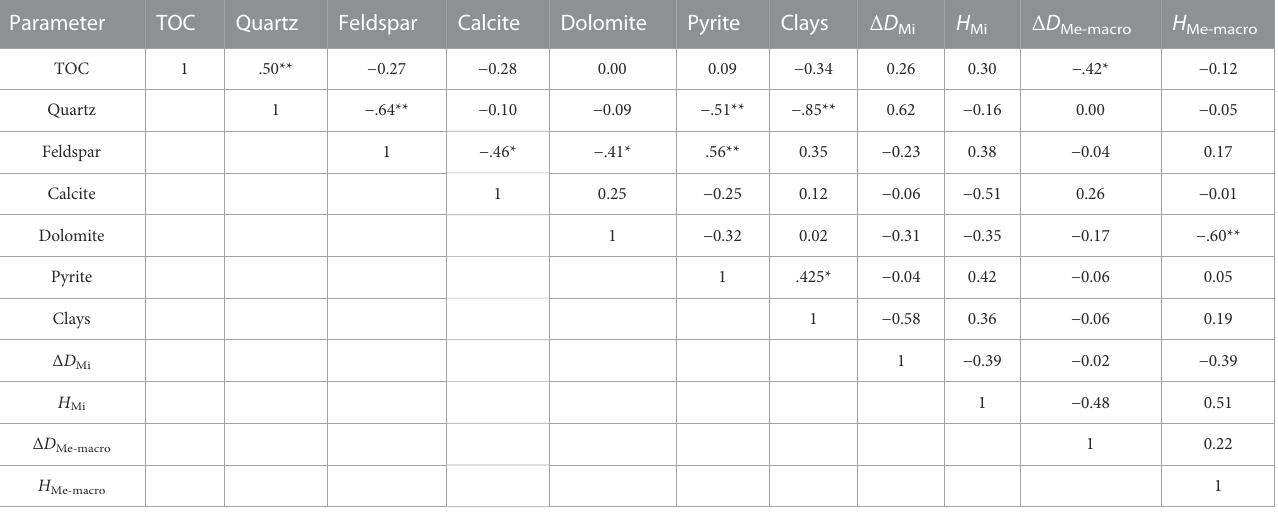
TABLE 3 Relationship between mineral composition and values of △ D and H for shales from well CS#1.